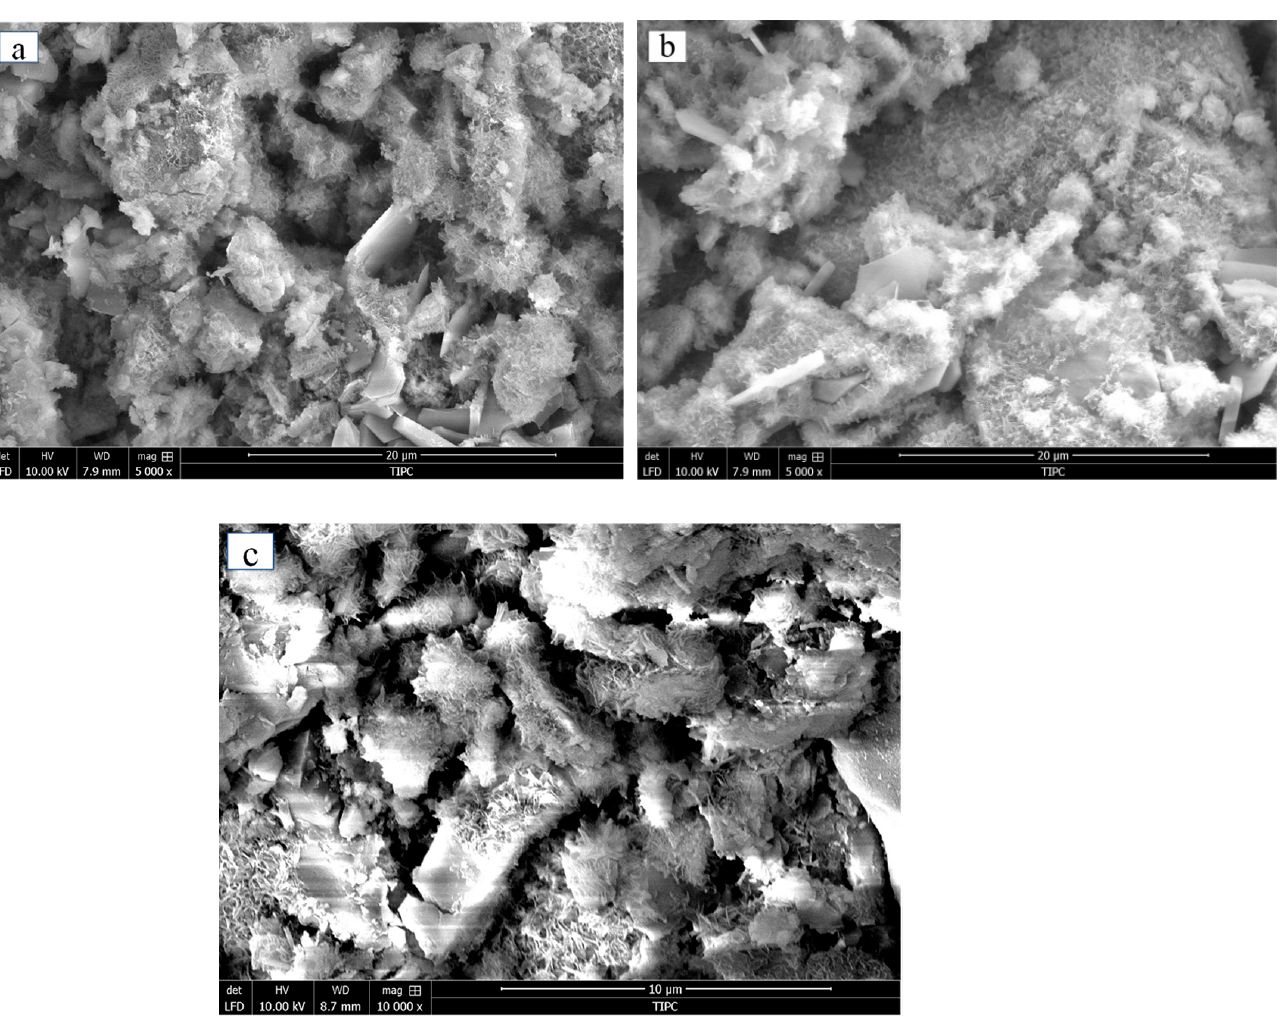
Figure 10. SEM images of samples with different solid content. ( a ) b/w ratio of 1:4, solid content of 72%, curing time of 7 d; ( b ) b/w ratio of 1:8, solid content of 72%, curing time of 7 d; ( c ) b/w ratio of 1:10, solid content of 72%, curing time of 7 d;